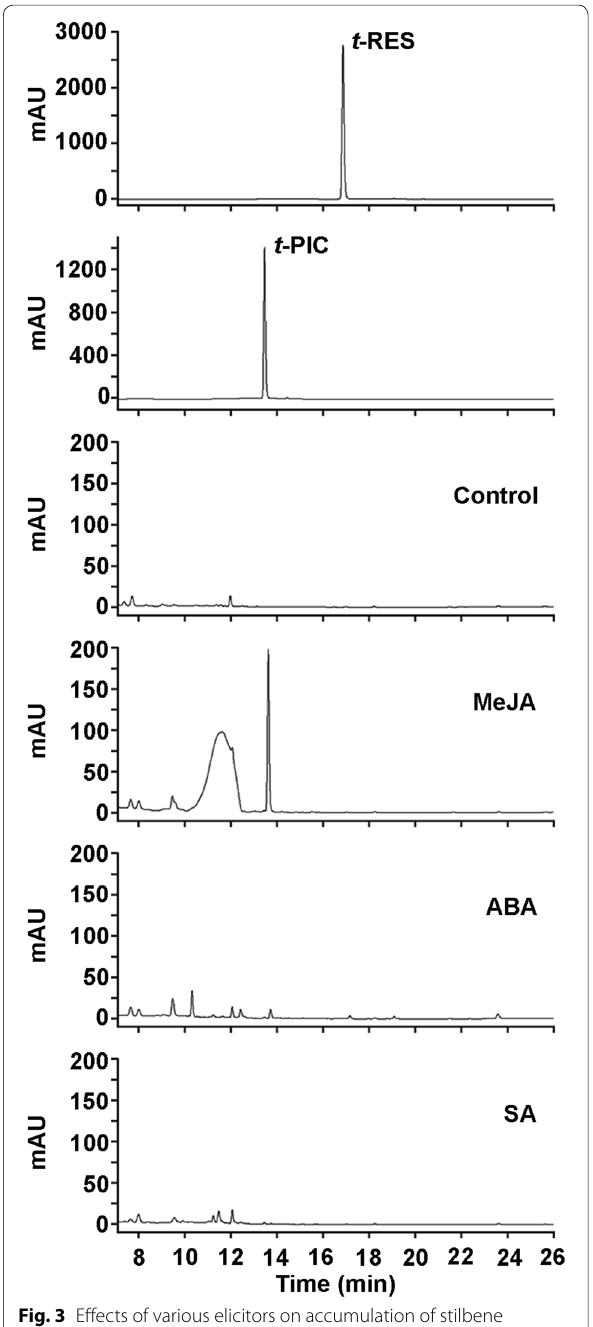
Fig. 3 Effects of various elicitors on accumulation of stilbene compounds in grapevine cell cultures. The cells were pre‑cultured for 7 days and harvested 2 days after elicitation with the indicated elicitors. Samples were extracted with methanol and subjected to HPLC analysis. HPLC analysis was performed using a C18 reverse‑phase column at 300 nm. Chromatograms t ‑RES and t ‑PIC represent the authentic standards trans ‑resveratrol and t ‑piceid with retention times of 17.200 and 13.568 min, respectively. Con, untreated control. Chromatogram MeJA indicates the t ‑piceid production in the elicited cells 2 days after elicitation with 100 µM